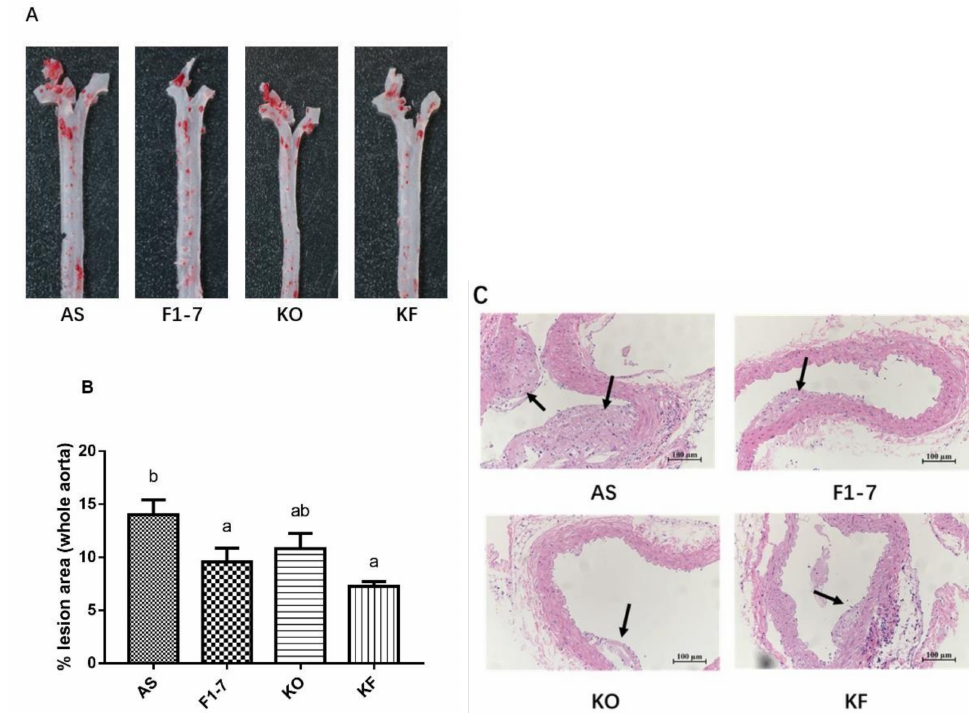
Figure 1. ( A ) Representative images of the aorta Oil Red O staining plaque burden (n = 4). ( B ) The quantification of lesion in percentage area was analyzed by Image J software. Different letters indicate significant differences from each group, p < 0.05. ( C ) H&E staining of the aorta section (n = 3). The arrow points to the plaque of the